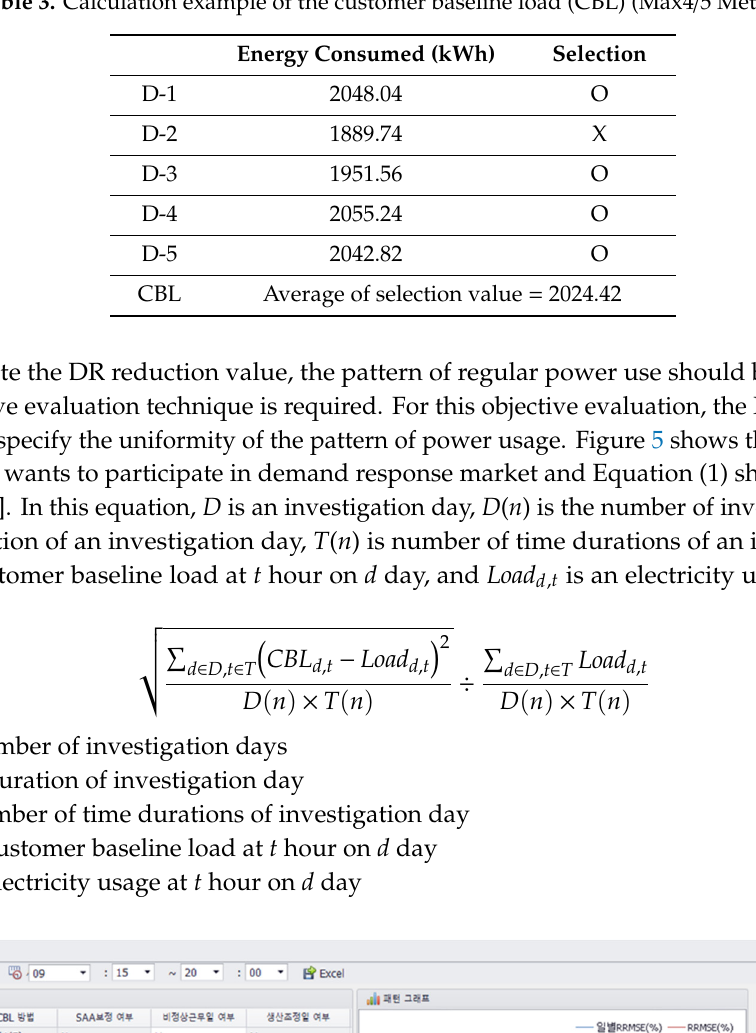
Table 3. Calculation example of the customer baseline load (CBL) (Max4 / 5 Method).